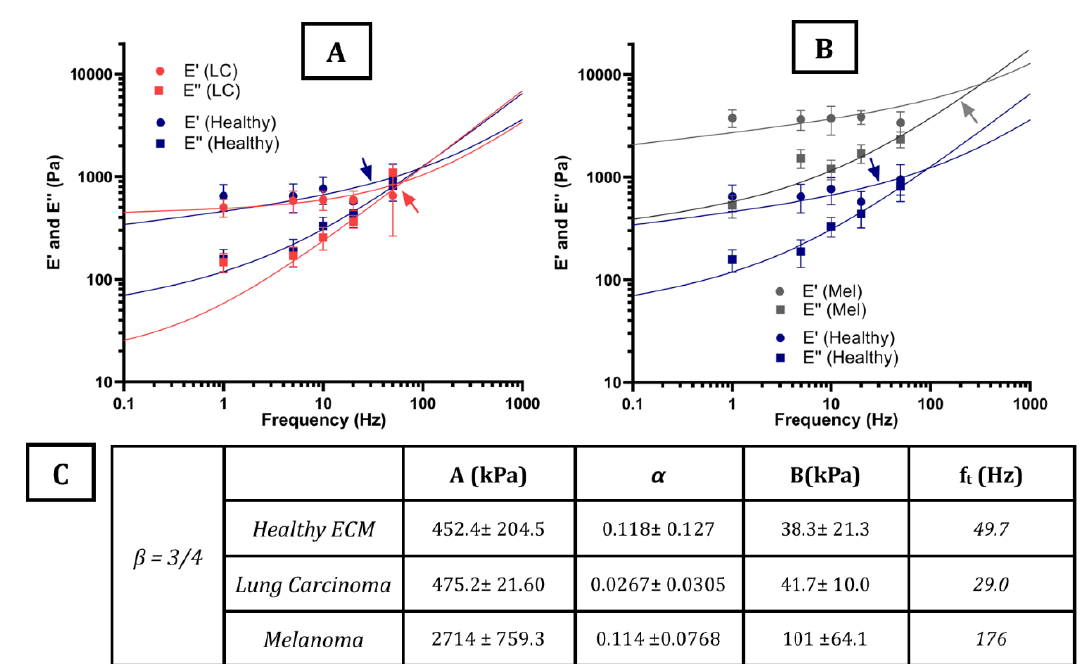
Figure 3. Frequency dependent loss (E′) and storage (E″) modulus as measured by dynamic mechanical analysis (DMA) of the ECM of healthy lung and the ECM-rich regions of ( A ) lung carcinoma (CAR) and ( B ) melanoma (MEL) lung macrometastasis. Solid lines represent the fits of the two-power law model. Arrows indicate the transition frequency. Fit parameters and transition frequency are detailed in table ( C ).